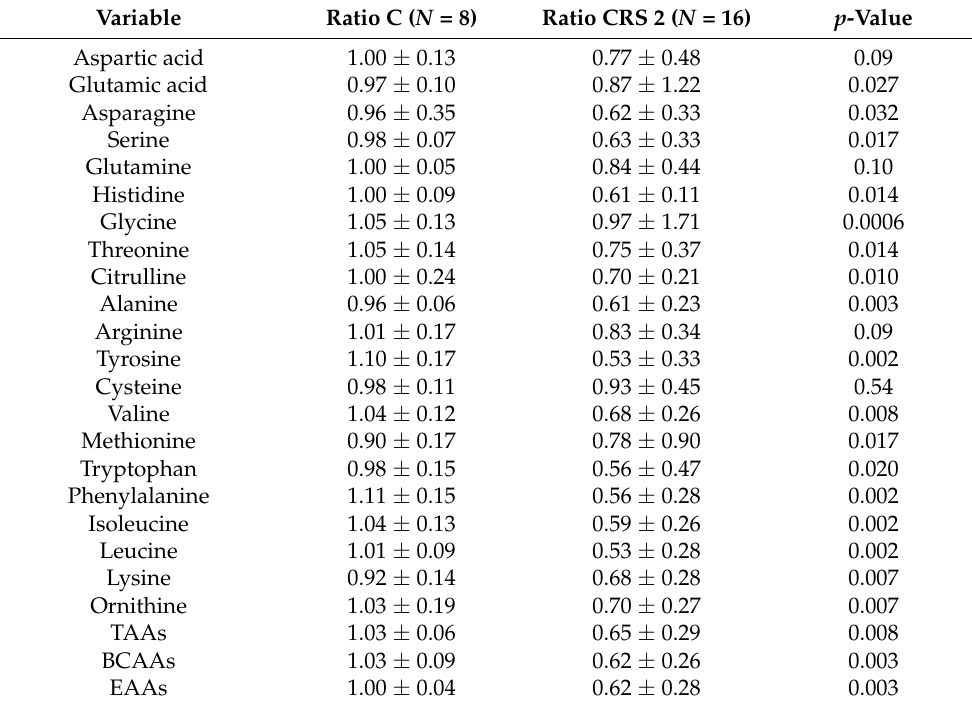
Table 5. Plasma arterial/venous ratios (%) in controls (C) and cardiorenal syndrome type 2 (CRS 2)